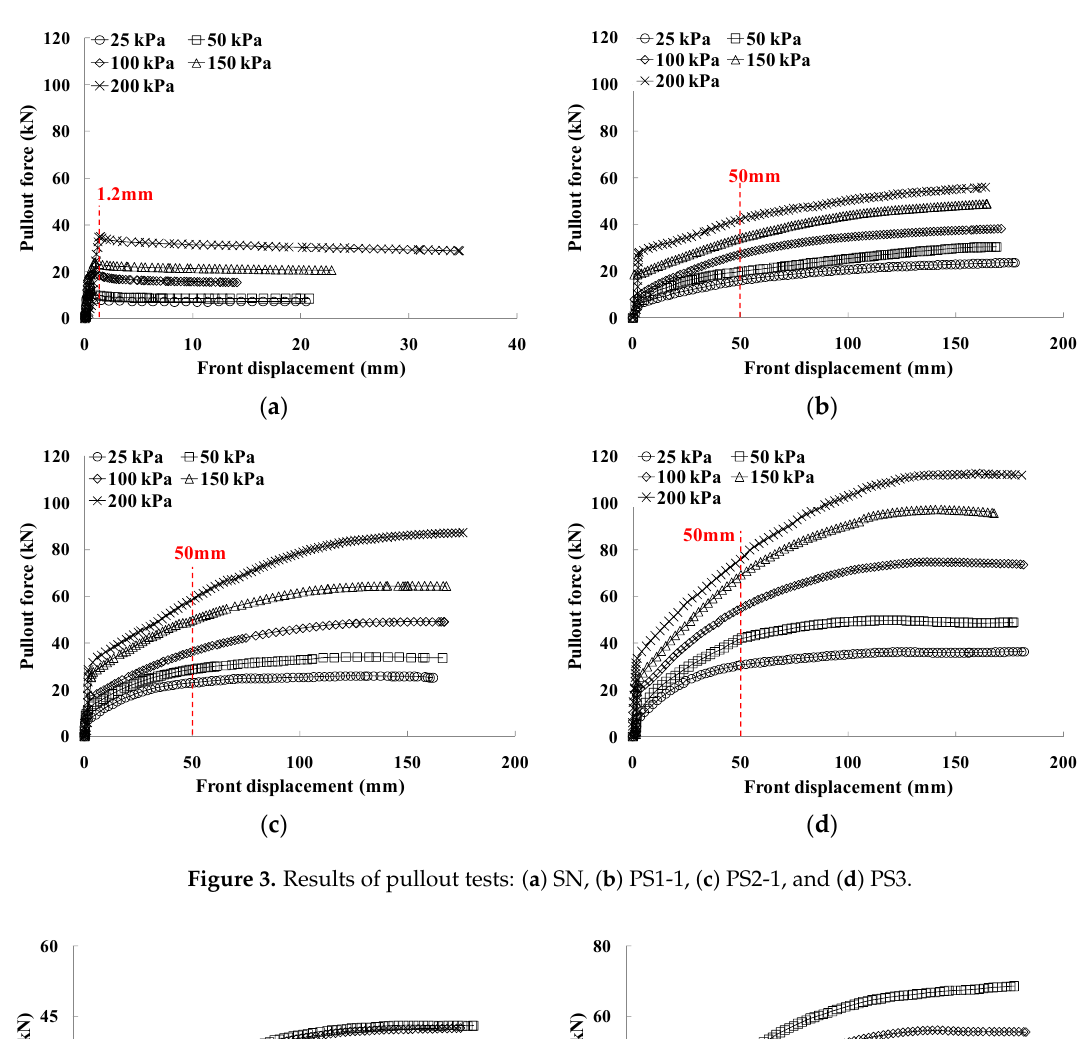
Figure 3. Results of pullout tests: ( a ) SN, ( b ) PS1-1, ( c ) PS2-1, and ( d ) PS3.